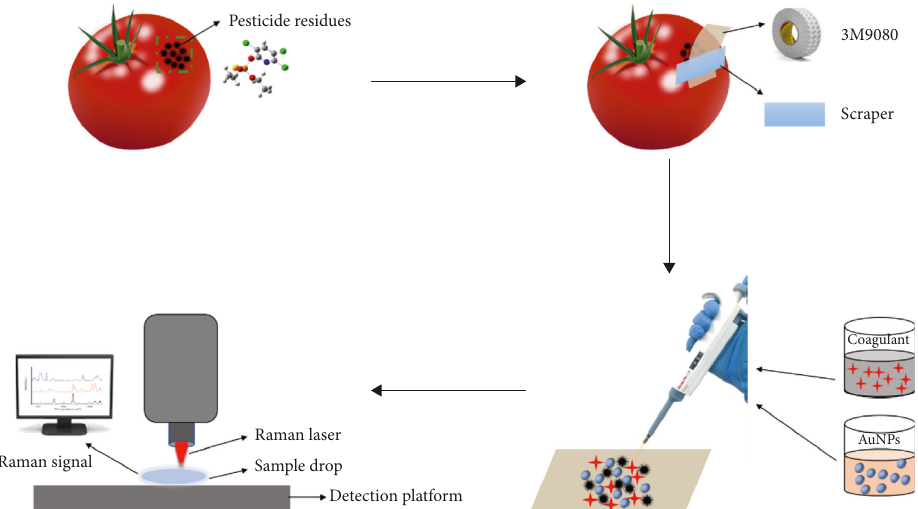
Figure 1: Sampling and detection process of pesticide residues on tomato surface based on flexible surface-enhanced Raman scattering (SERS)